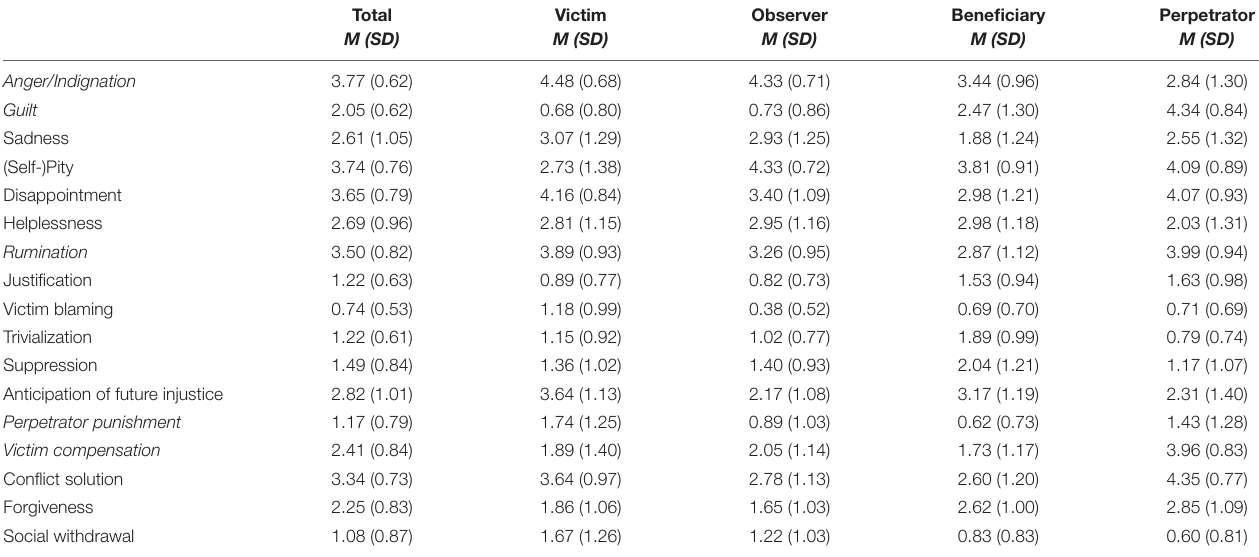
TABLE 3 | Mean responses to injustice averaged across all 12 situations (total) and averaged across the three situations per justice-sensitivity perspective.